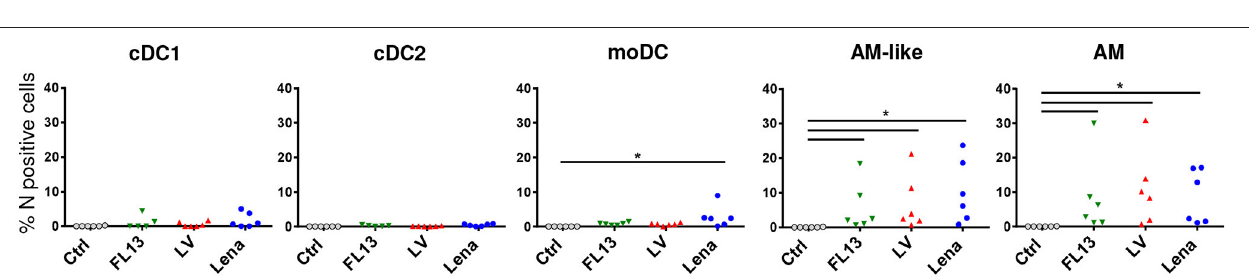
FIGURE 3 | DCs are not infected by Lelystad and Flanders13 in vitro. MPC enriched parenchymal cells were infected for 16h at MOI 0.5 with Flanders13 (FL13, Green triangle), Lelystad (LV, Red triangle), and Lena (Blue circle) strains. Mock-infected MPC were used as control (Ctrl). The cells were stained and gated as in Figure 1 , except the additional step of an intracellular viral N protein staining. Data are representative of 6 independent experiments. Wilcoxon matched-pairs signed rank test was performed. * p < 0.05.